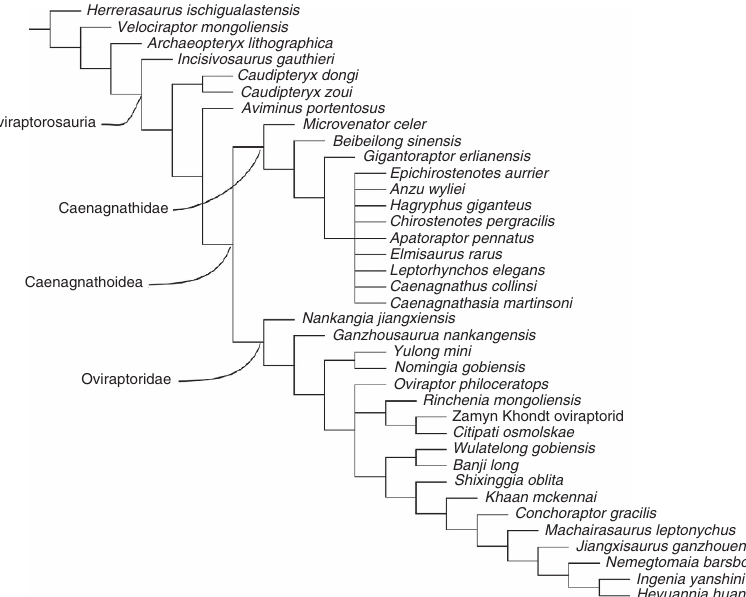
Figure 6 | Phylogenetic position of Beibeilong sinensis gen. et sp. nov. The strict consensus tree of 608 most parsimonious trees, obtained from a phylogenetic analysis of 37 taxa and 250 characters. Consistency index ¼ 0.482. Retention index ¼